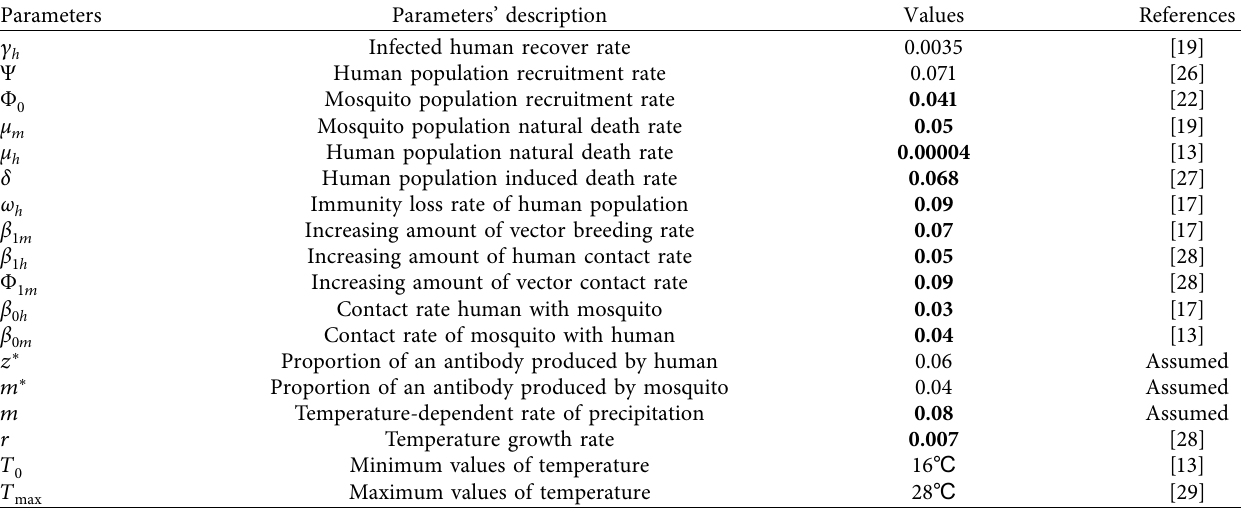
Table 4: Parameter description and taken values for model